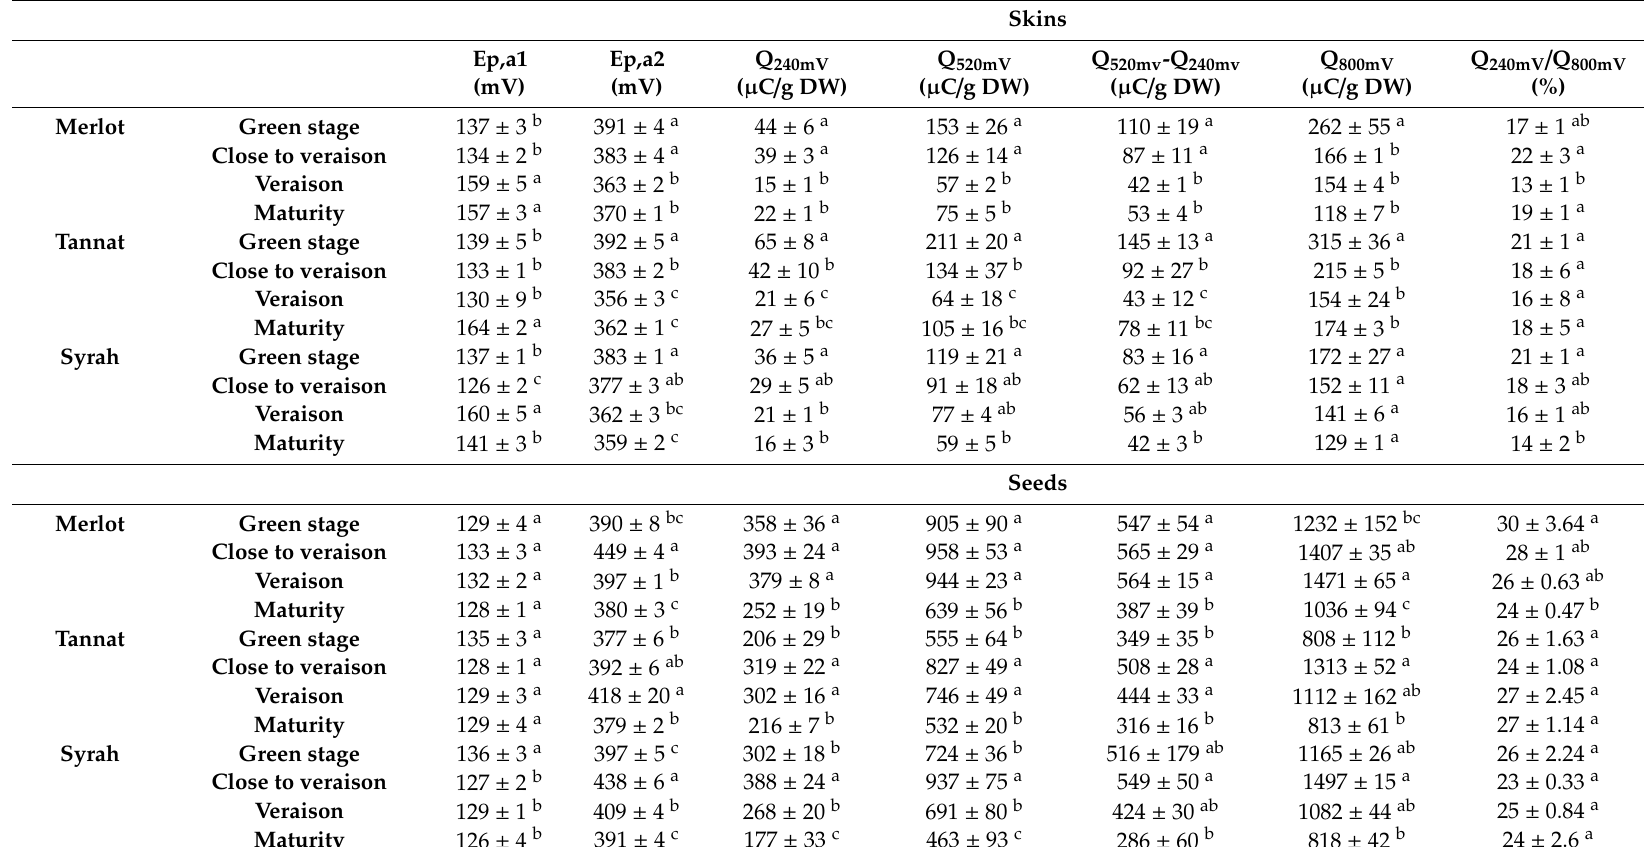
Table 4. Potential of peaks and cumulative peak areas for skins and seeds of Merlot, Tannat, and Syrah during ripening.